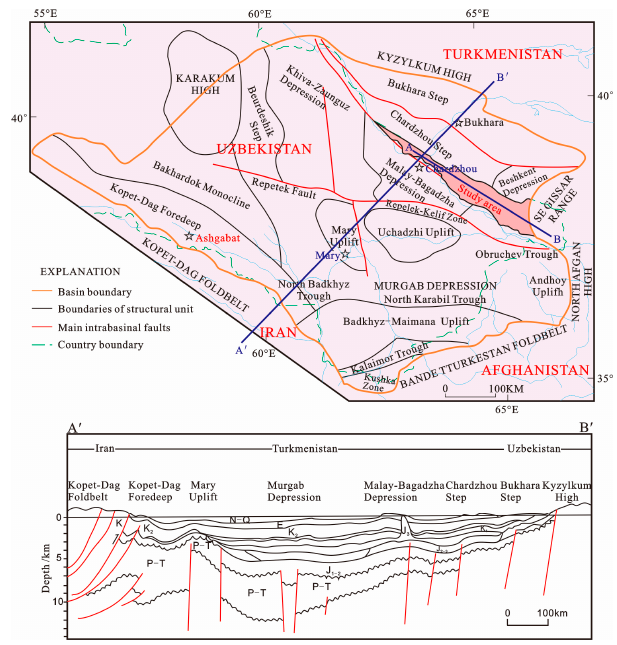
Figure 1. Overview of regional structure in the Amu Darya right bank area.